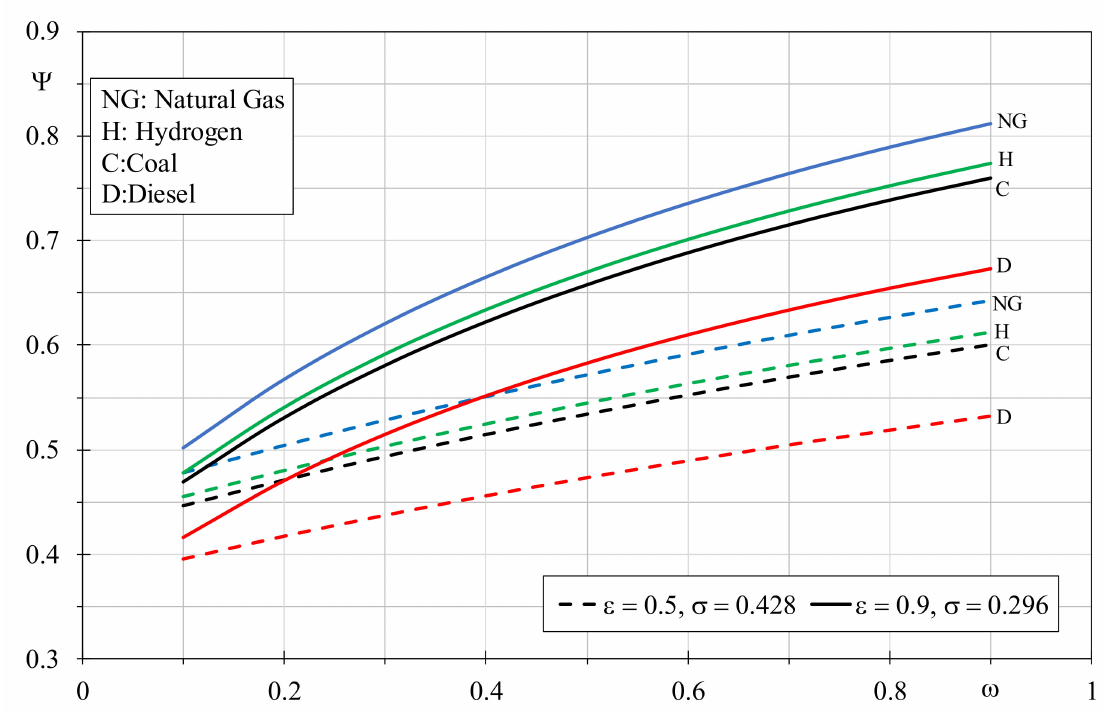
Figure 9. EQI related to the thermal capacity ratio for the considered fuels for different couples of values concerning heat exchanger efficiency and dimensionless temperature factor.